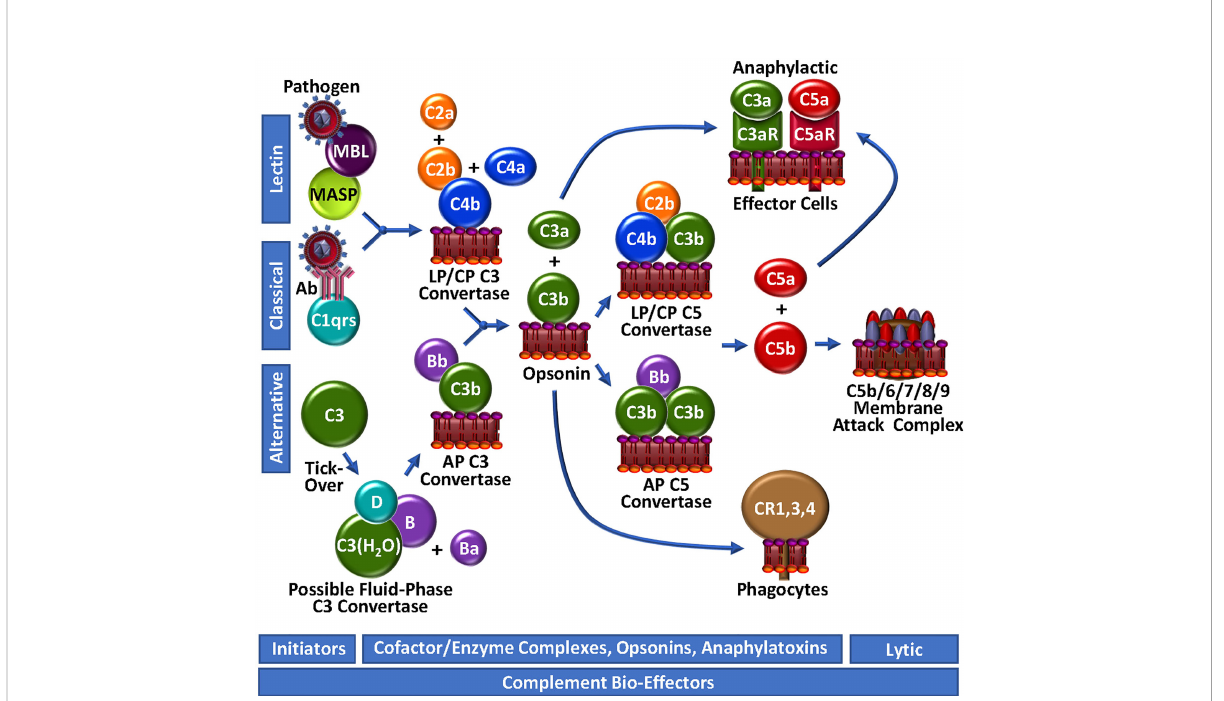
FIGURE 2 Complement Unwebbed. The LP and CP are initiated by contact with a foreign particle or damaged cells, whereupon C4b is surface-deposited in complex with C2b, forming the LP/CP C3 convertase. The AP is continuously surveying the circulation for foreign bodies by spontaneous thio-ester hydrolysis and possible formation of a highly unstable fl uid-phase C3 convertase. Either the LP/CP or AP C3 convertase may result in deposition of surface C3b and generation of respective C5 convertases. C5b production triggers the assembly of the lytic membrane attack complex by the addition of C6, C7, C8 and multiple C9 molecules. Surface-bound C4b and C3b are opsonic, as are degradation fragments of C3b (not depicted), which associate with complement receptors (CR1,3,4). C3a and C5a are anaphylactic, associating with C3aR and C5aR,